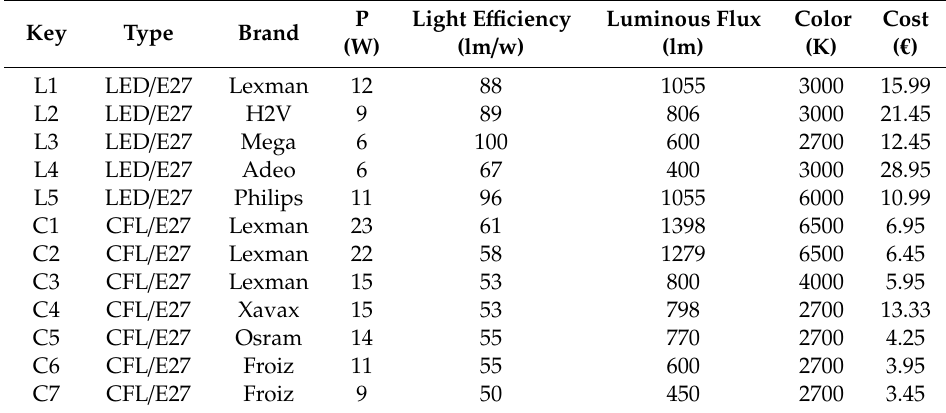
Table 1. Summary of the main characteristics of the evaluated light emitting diode (LED) and compact fluorescent light (CFL)